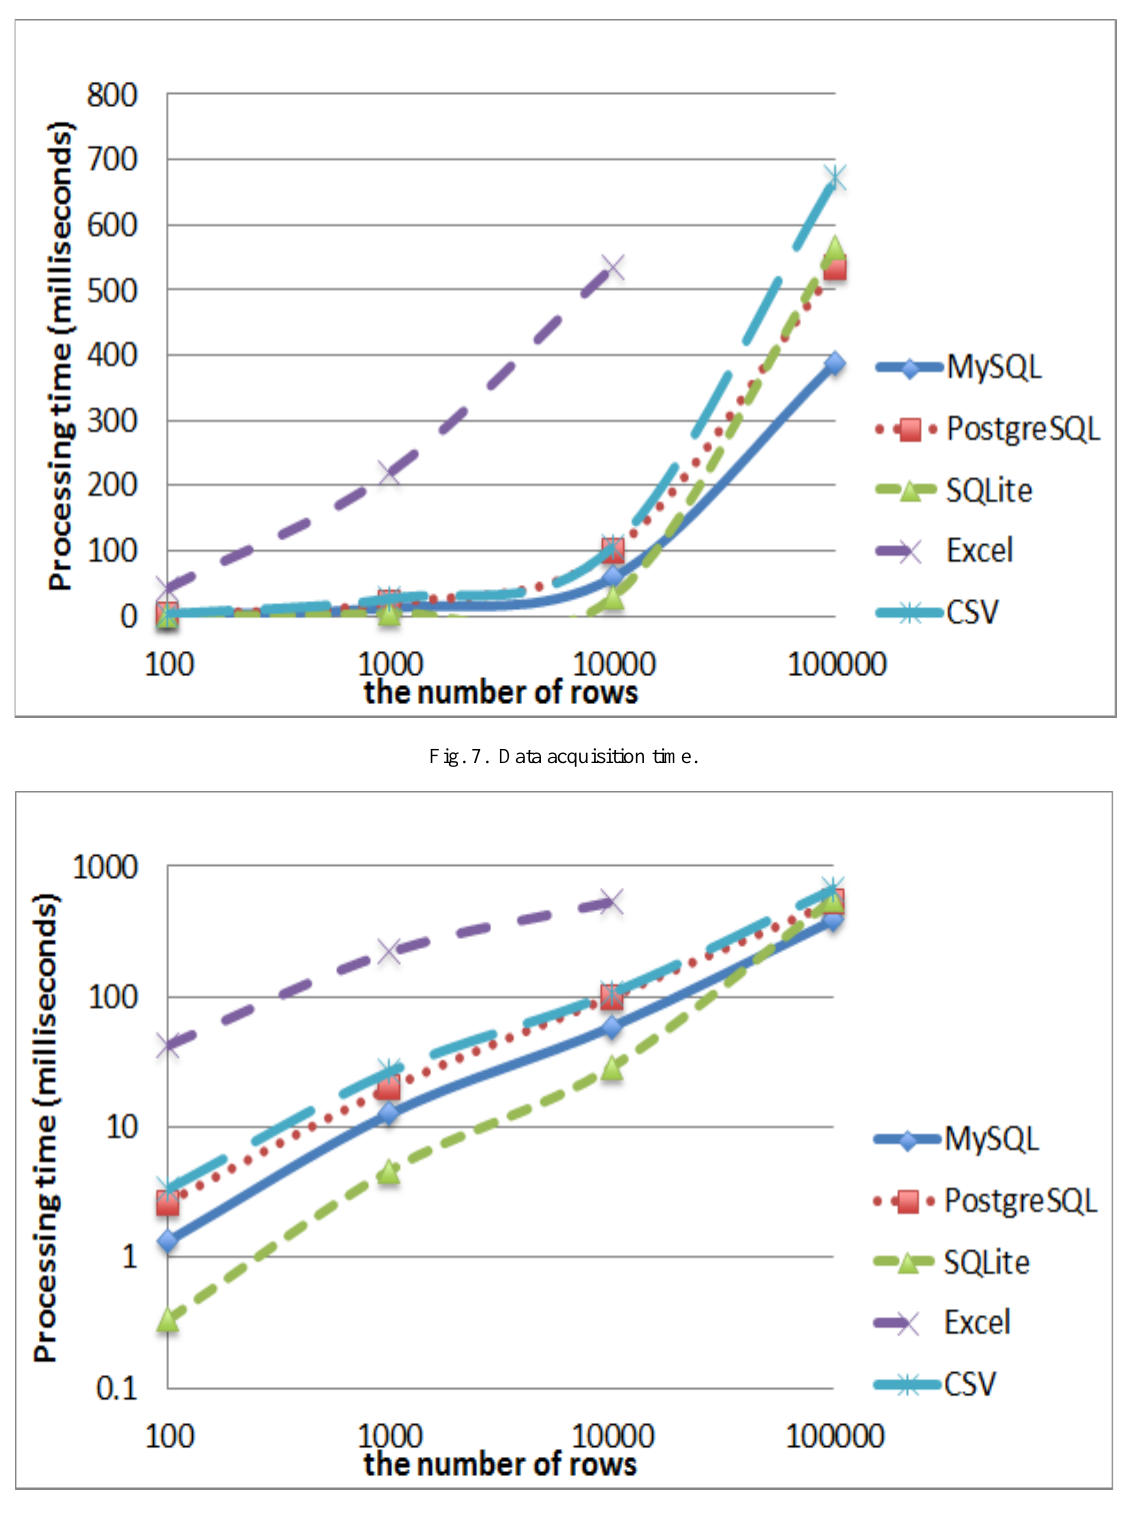
Fig. 8. Data acquisition time (logarithmic